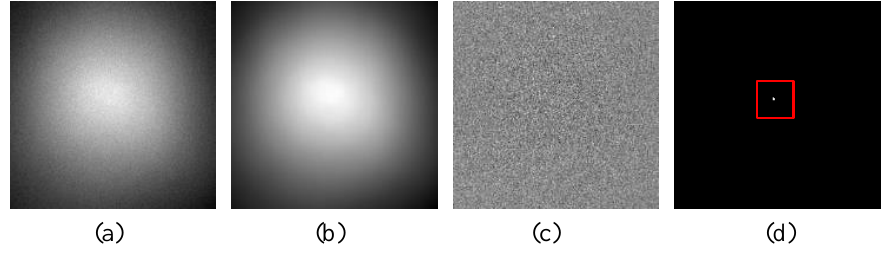
Figure 2. The sparse target cannot be separated effectively. ( a ) The original video frame image. ( b ) The low-rank background image. ( c ) The difference image. ( d ) The target image.